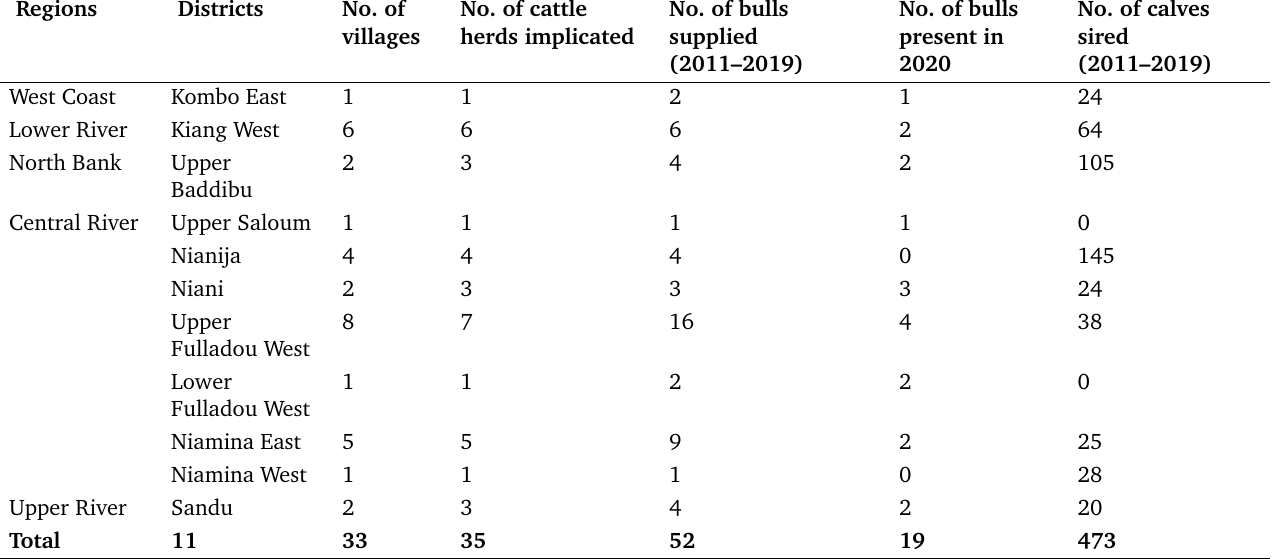
Table 2. Account of disseminated bulls at the Multiplier tier. Additional details are provided in Supplemental Table